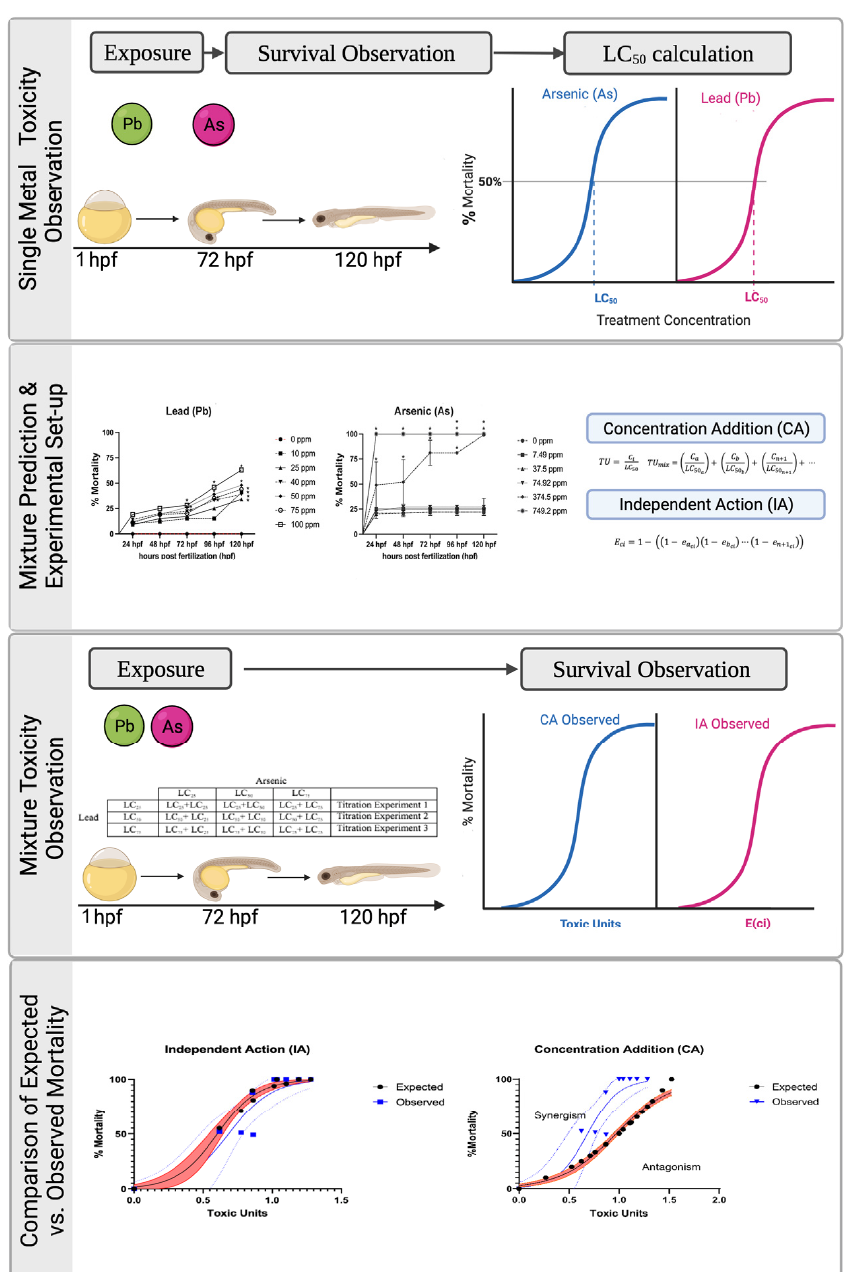
Figure 1. Experimental overview of study. Zebrafish embryos were dosed with a concentration range of each metal to determine lethal concentrations (LC) for benchmark treatment groups in the mixture titration experiments and for predictive mathematical modeling. The expected and observed results were compared among the mathematical models using the prediction deviation ratio and Chi-square test. Type of mixture interaction was determined using regression modeling.